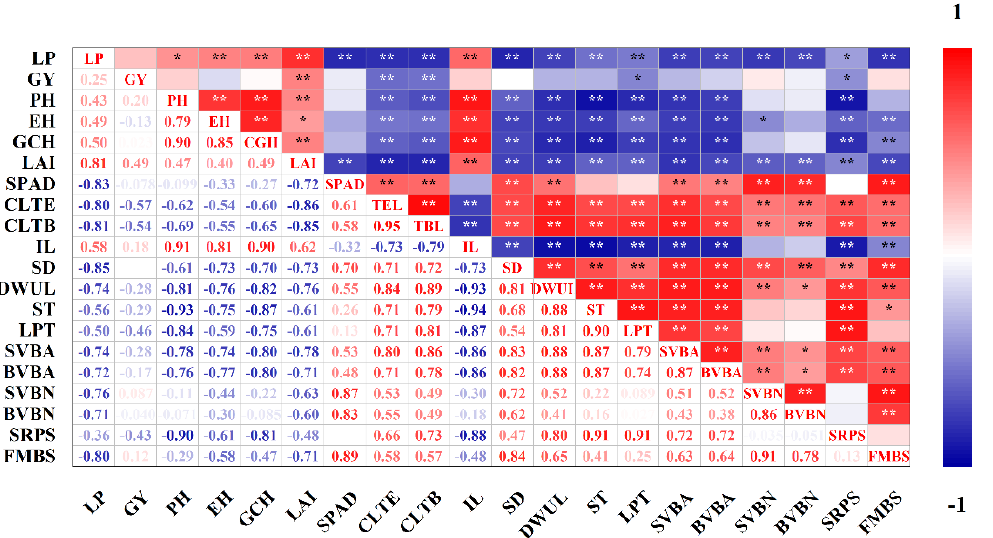
Figure 8. Correlation analysis. LP, lodging percentage; GY, grain yield; PH, plant height; EH, ear height; GCH, gravity center height; CLTE, canopy light transmittance of the ear layer; CLTB, canopy light transmittance of the bottom layer; IL, internode length; SD, stalk diameter; DWUL, dry weight per unit length; ST, sclerenchyma thickness; LPT, lignified parenchyma thickness; SVBA, the area of small vascular bundles; BVBA, the area of big vascular bundles; SVBN, the number of small vascular bundles; BVBN, the number of big vascular bundles; SRPS, stalk rind penetration strength; FMBS, maximum bending strength in the field. *, significant at 0.05 probability level. **, significant at 0.01 probability level.